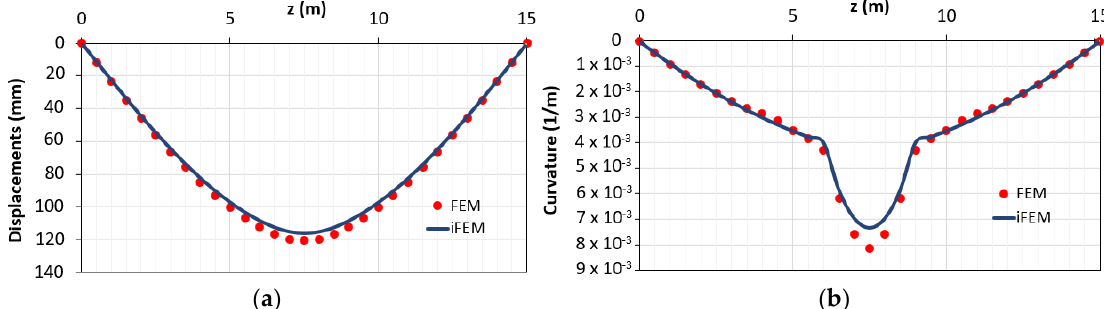
Figure 11. Results obtained with the proposed method in cases of lack of data in the plastic area in terms of ( a ) displacements; ( b ) curvature.